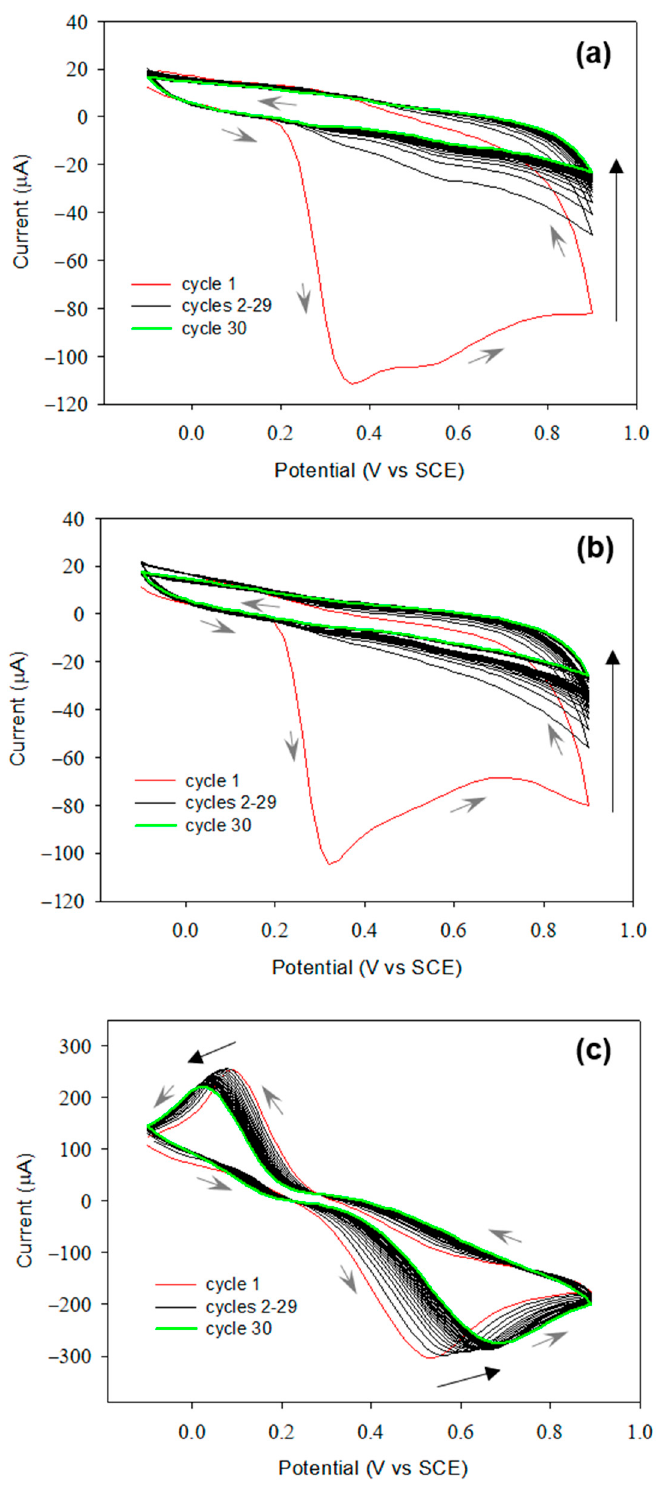
Figure 4. Cyclic voltammograms relevant to 5mM oAP and 20mM dopamine ( a ); 5 mM oAP ( b ); 20 mM dopamine ( c ) in acetate buffer solution (I = 0.1 M, pH 5), at a bare platinum electrode acquired at 100 mV/s by scanning the potential in the range − 0.1/0.9 V for 30 cycles. The black arrows indicate the current evolution upon subsequent cycles, whereas the grey arrows indicate the scan direction.